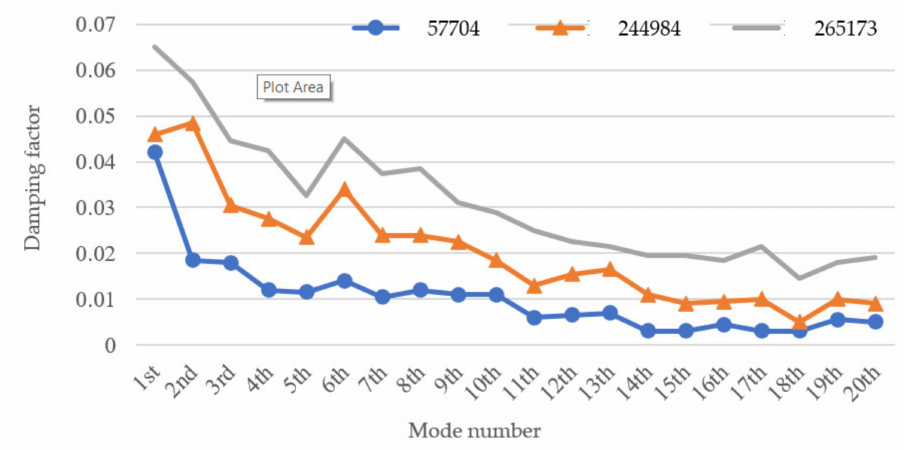
Figure 21. Damping factors of decomposed signals of the first 20 modes of the three wooden utility